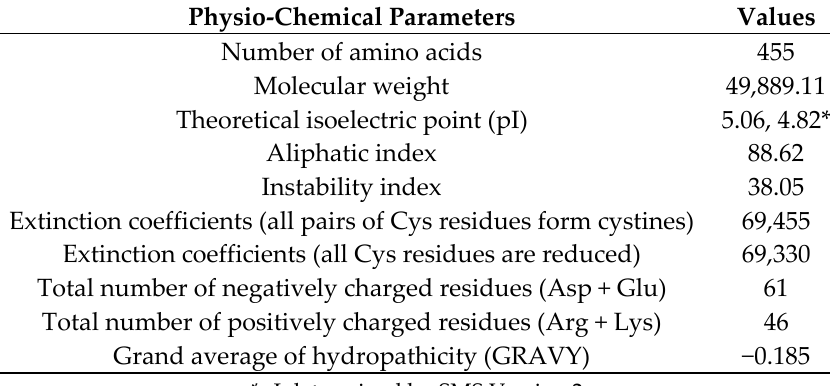
Table 1. Physico-chemical Parameters.